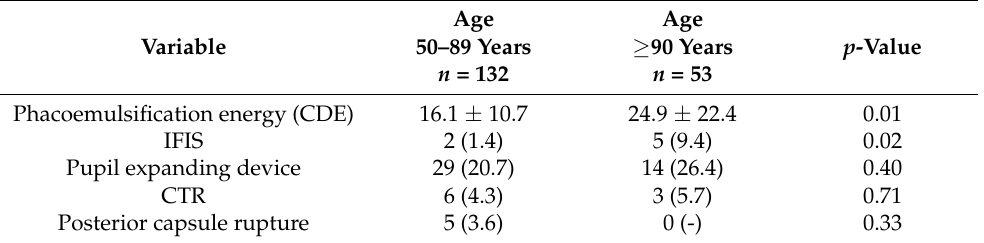
Table 1. Intraoperative procedures and complications in study populations.